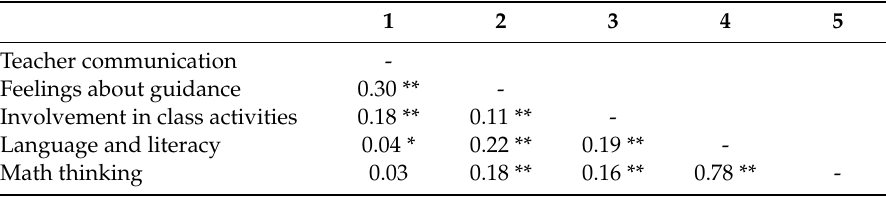
Table 3. Correlation matrix of dependent variables.